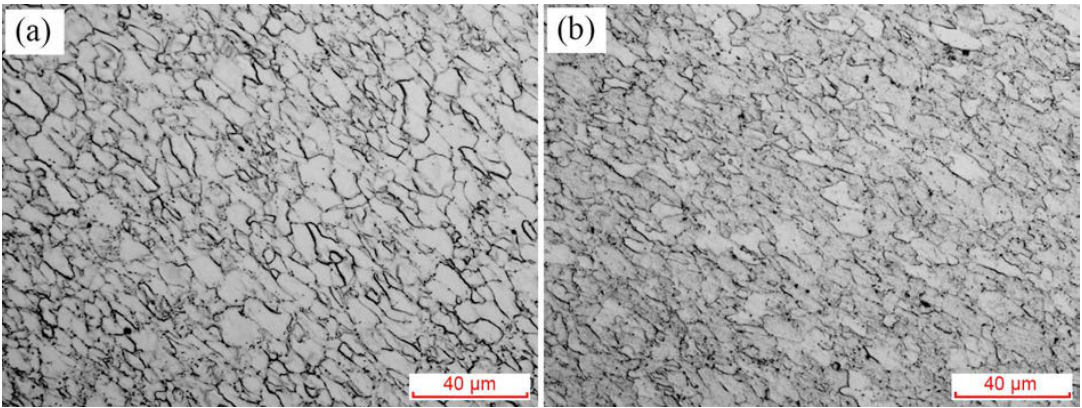
Figure 4. OM micrographs of cold-rolled microstructures: ( a ) 0.03V and ( b ) 0.16V.